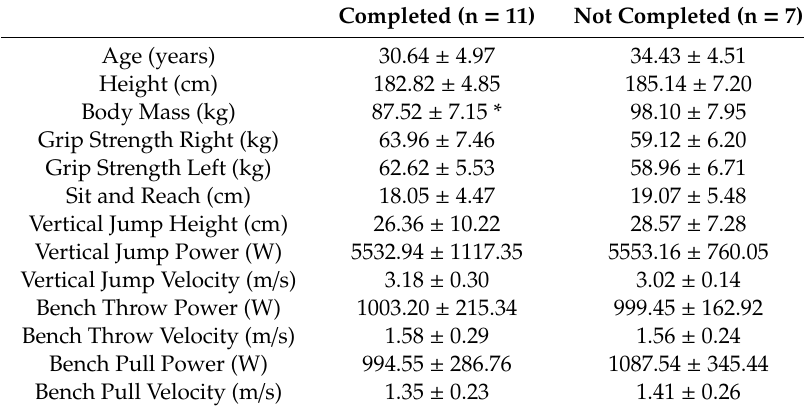
Table 1. Comparisonofcandidateswhocompletedanddidcompletetheselectioncourse. Datapresented as mean SD. * = Significant difference ( p <